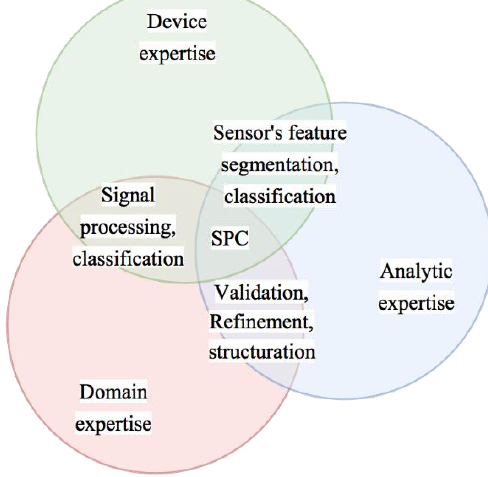
Figure 2 The Smart Point Cloud